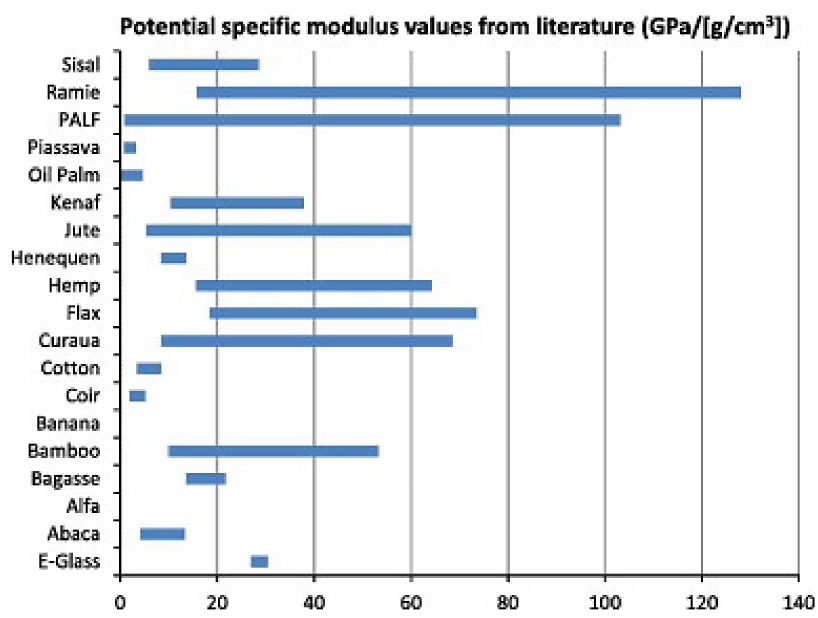
Figure 16. Comparison of values and ranges of potential specific modulus between natural and glass fibers [299]. Extracted with permission from